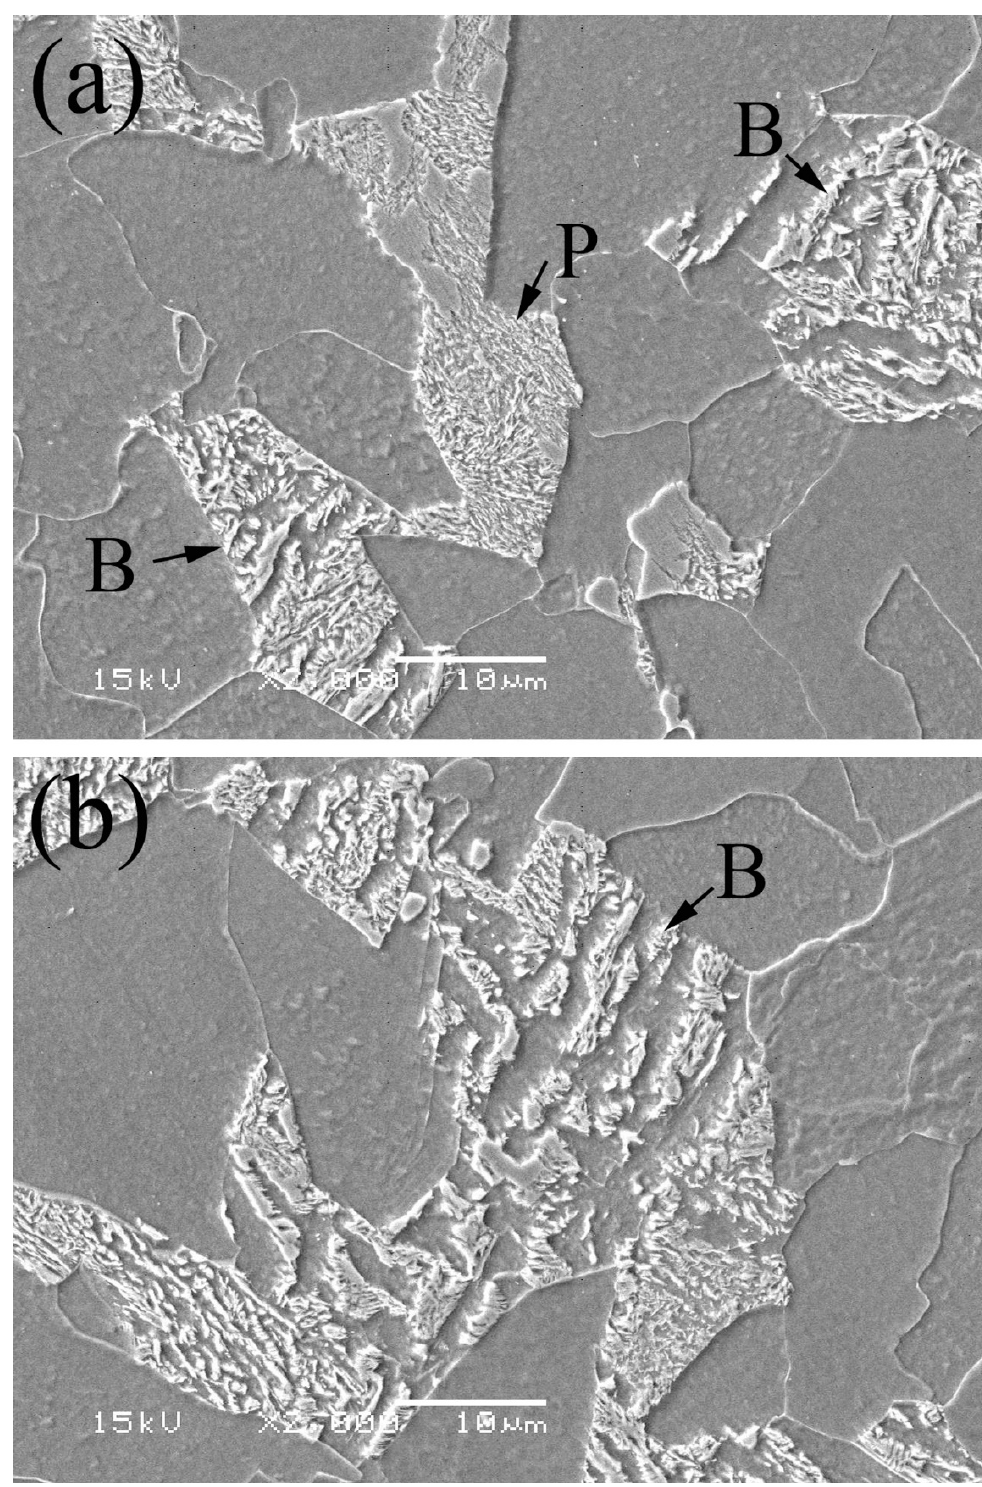
Figure 3. Different microstructures in N2-HR steel at high magnification SEM images: ( a ) pearlite, ( b ) bainite.